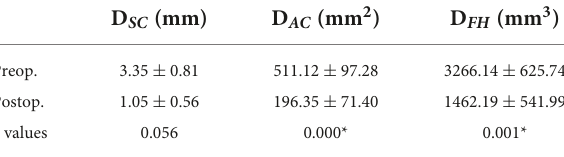
TABLE 4 Changes of parameters on computer-assisted design (CAD) models of the hip joint. D SC (mm) D AC (mm 2 ) D FH (mm 3 ) Preop. 3.35 ± 0.81 511.12 ± 97.28 3266.14 ± 625.74 Postop. 1.05 ± 0.56 196.35 ± 71.40 1462.19 ± 541.99 p values 0.056 0.000*